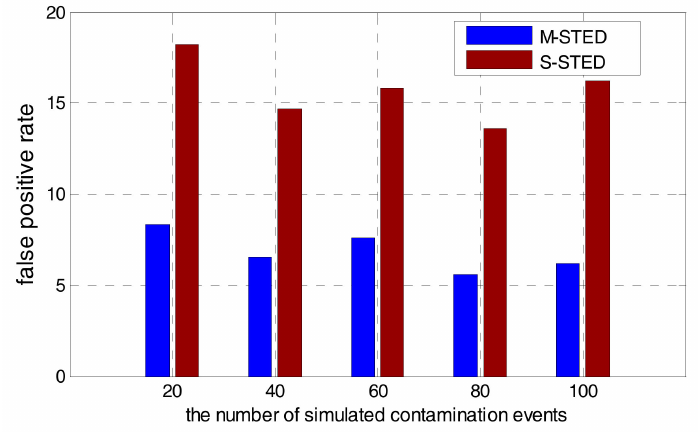
Figure 10. Comparison of false alarm rates between M-STED and